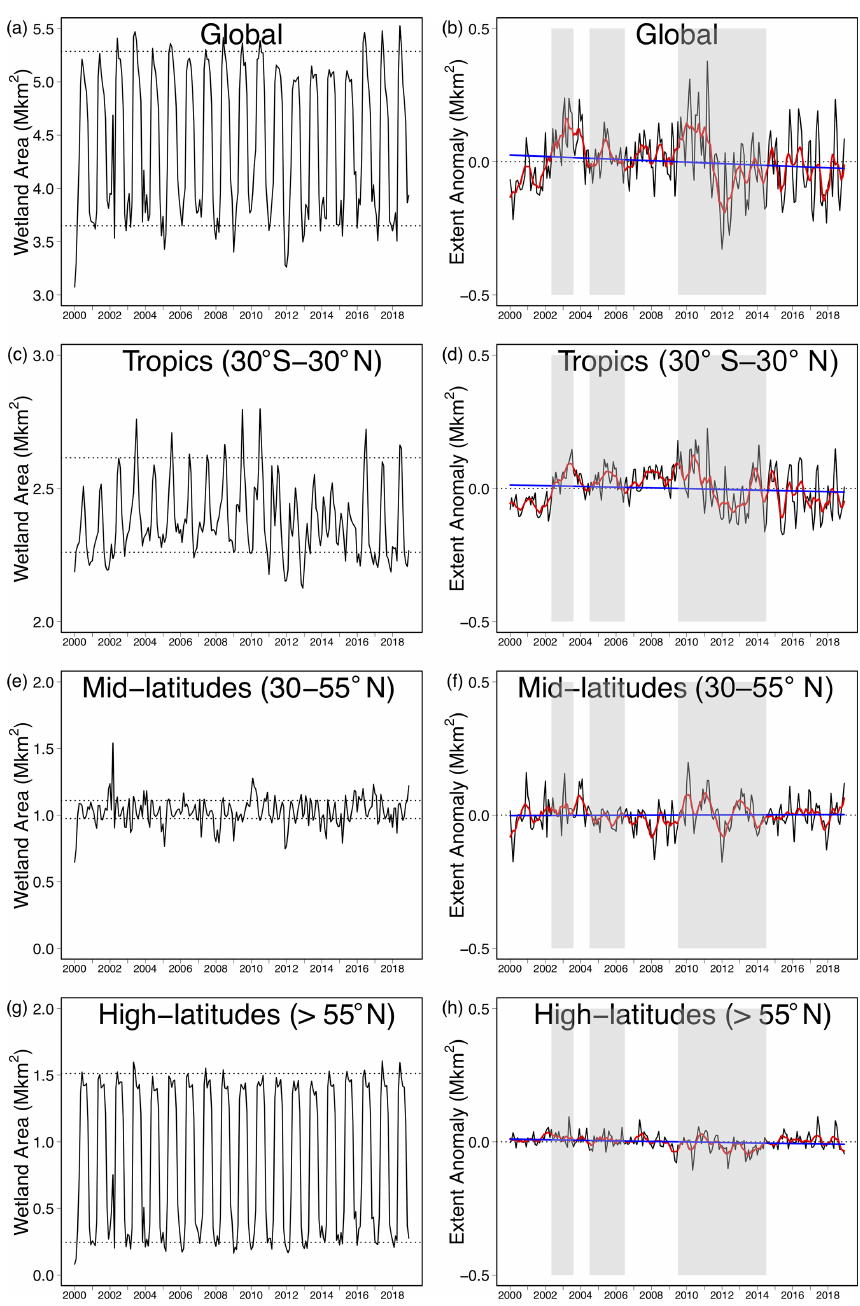
Figure 7. The WAD2M wetland extent and their anomalies from 2000–2018. Monthly mean wetland extent (left column; a , c , e , g ) for 2000–2018 in black, for the globe, the tropics (30 ◦ S–30 ◦ N), and mid-latitudes (30–55 ◦ N) and northern high latitudes (latitudes > 55 ◦ N). Horizontal dotted lines in the left column panels represent the mean annual maximum and the mean annual minimum. In the right column (b, d, f, h) , the deseasonalized anomalies (black) with the 6-month running mean (red) and linearly fitted trends (blue) using least-squares regression are listed. Shaded areas represent the La Niña phase from the NOAA multivariate ENSO